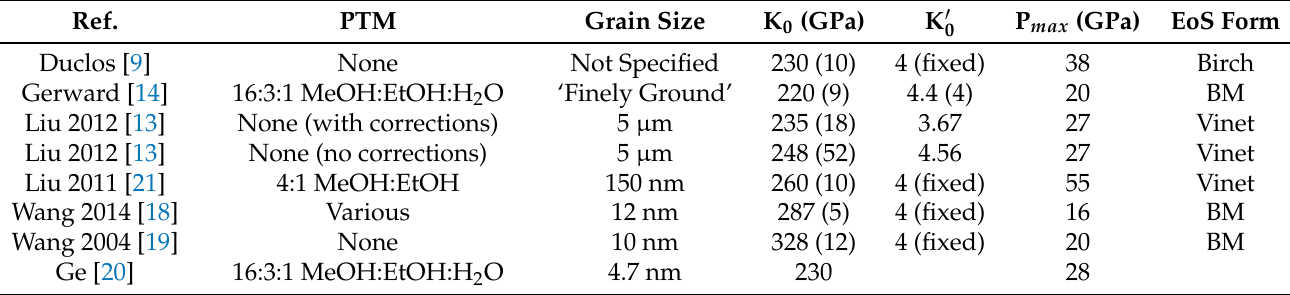
Table 1. Bulk moduli of Fm ¯3 m cerium dioxide measured using X-ray diffraction in diamond anvil cells. All studies use ruby fluorescence to determine pressure, except Wang 2004 which uses the equation of state of Pt, and Wang 2014 which uses both ruby and the equation of state of Au. ‘BM’ refers to the Birch-Murnaghan equation of state.